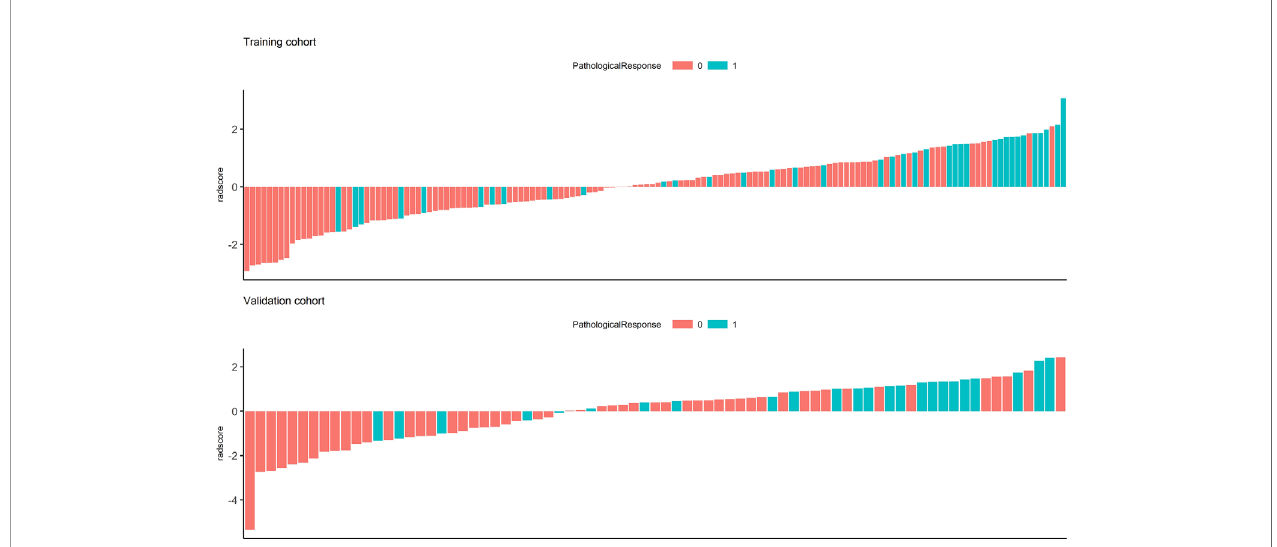
FIGURE 3 | Waterfall chart showing radscores for each patient in the training and validation cohorts. The red columns represent patients with minor pathological responses, and the green columns represent those with major pathological